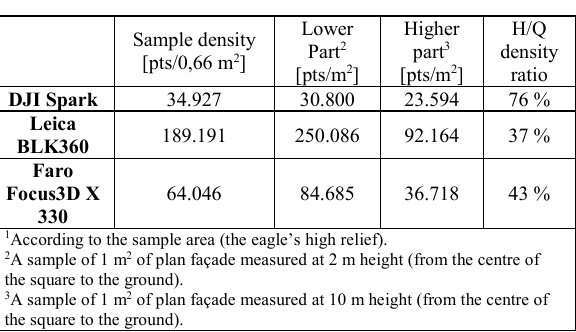
Table 10. Analysis on the samples area of the case study according to the three